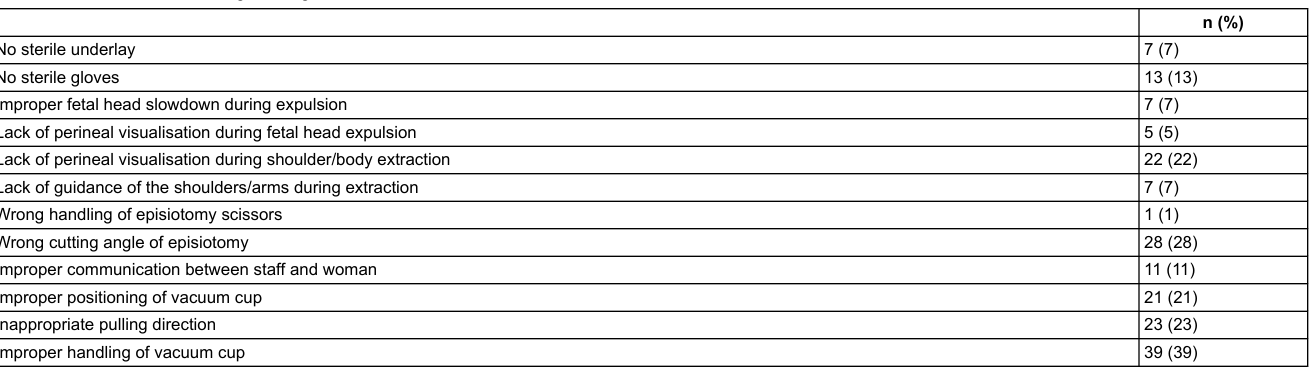
Table 3: Notable omissions during 100 vaginal